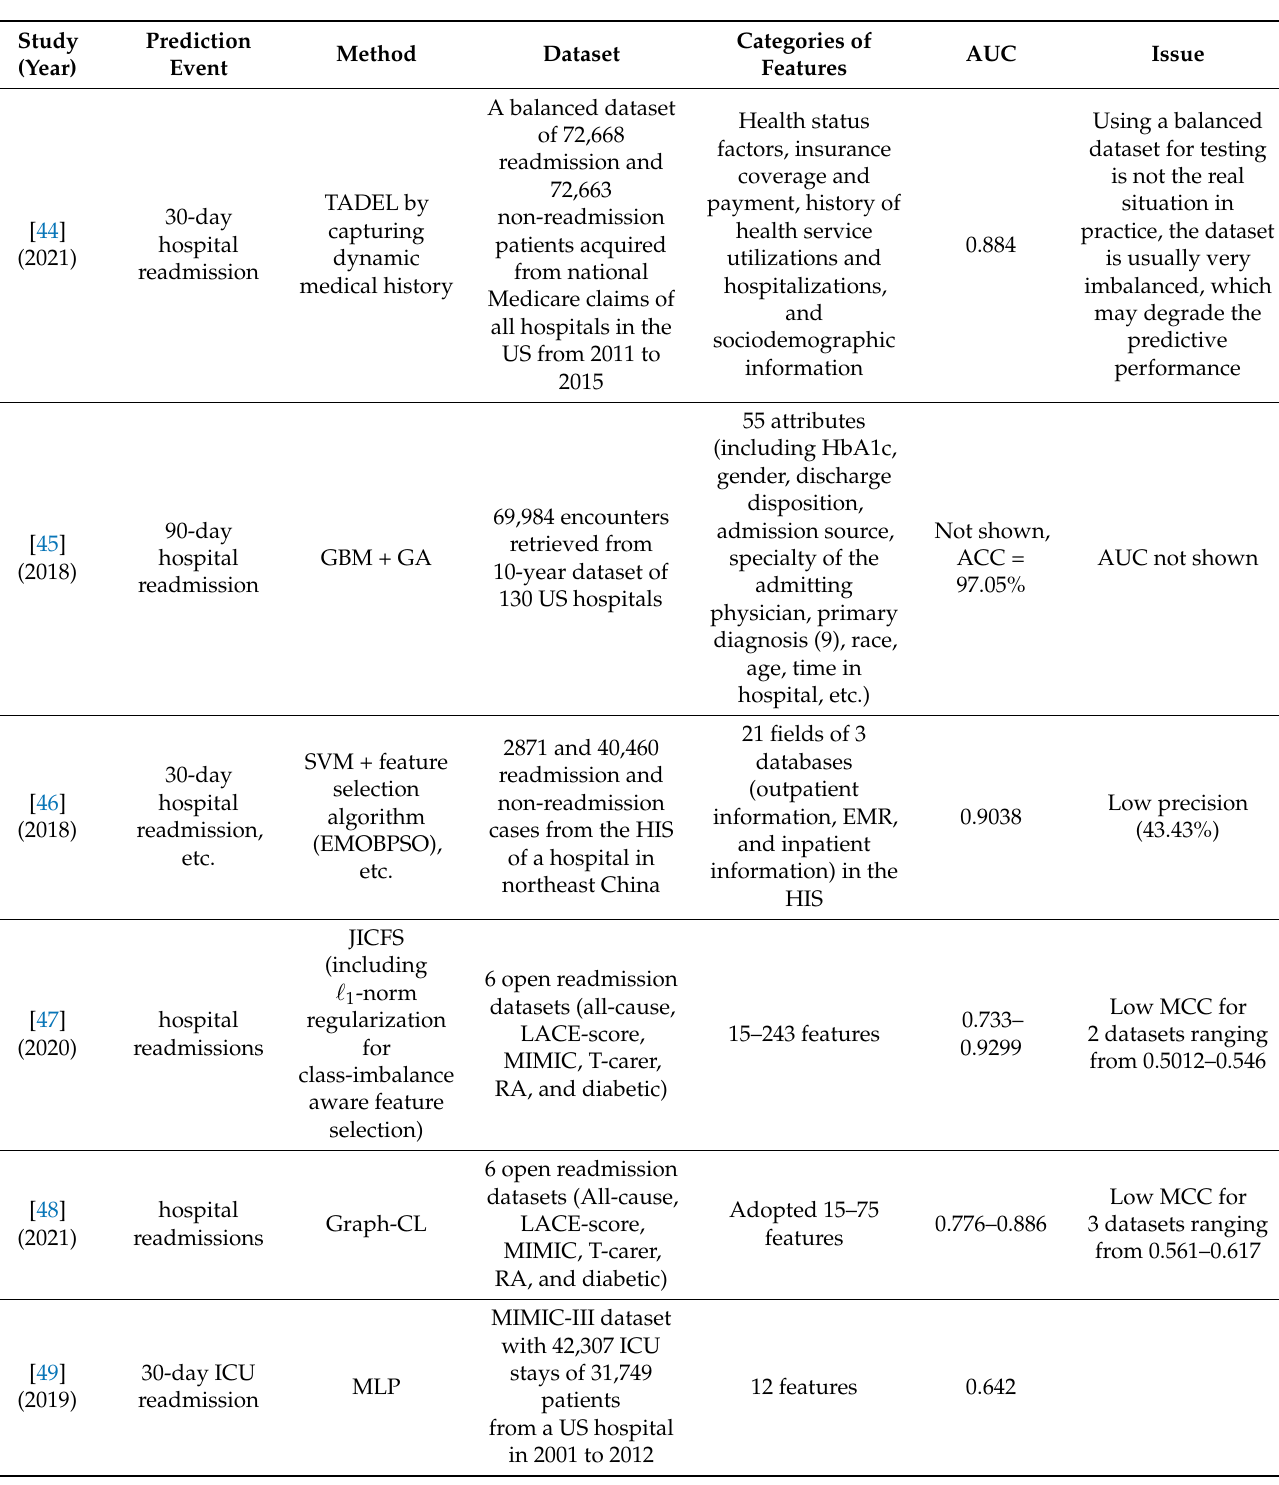
Table 2. Recent AI models for predicting hospital